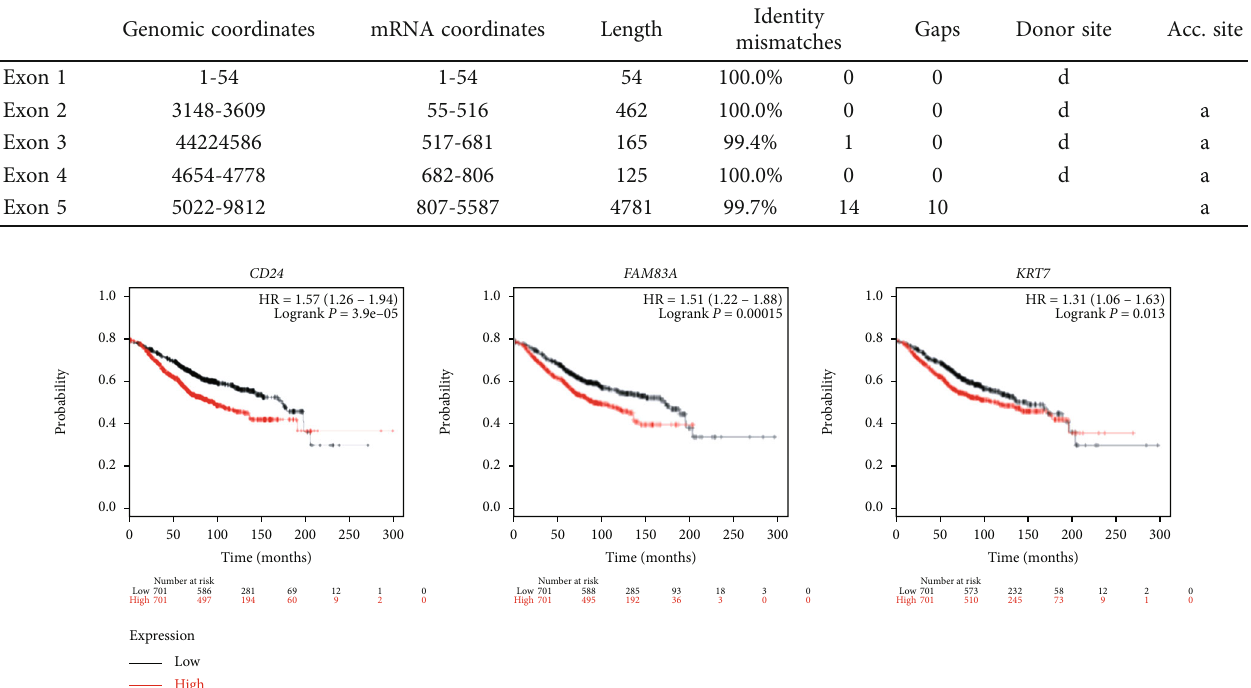
Figure 6: Kaplan-Meier prognostic value of core genes (log rank P < 0 : 05 considered statistically signi fi